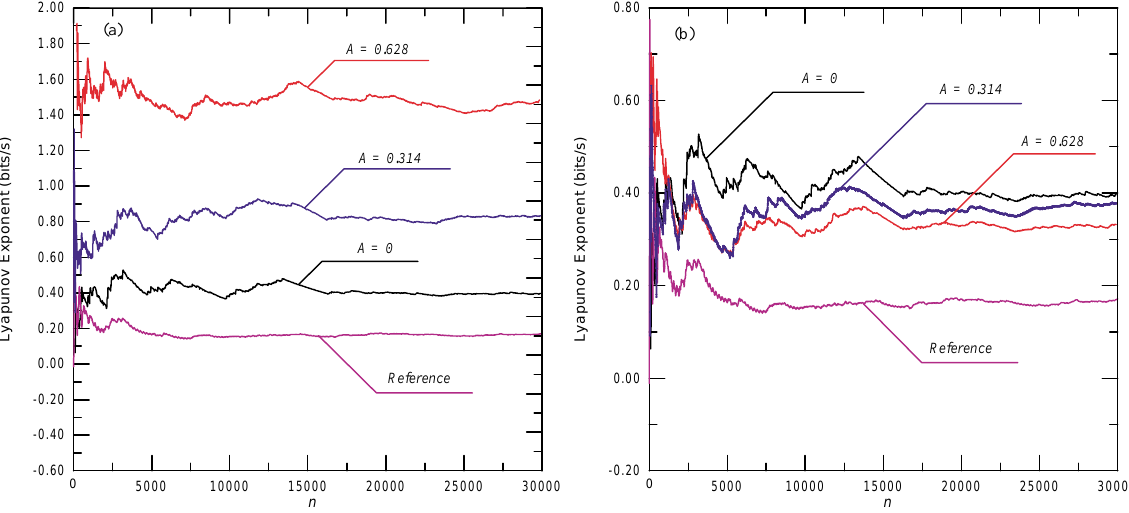
Fig. 8. Chaotic signal: Algorithm due to Wolf et al. (1985). (a) t EV = 1 ; (b) t EV = 5 for A = 0 . 314 and t EV = 10 for A = 0 . 628 . Lyapunov exponent, meaning that λ max = 0 , the